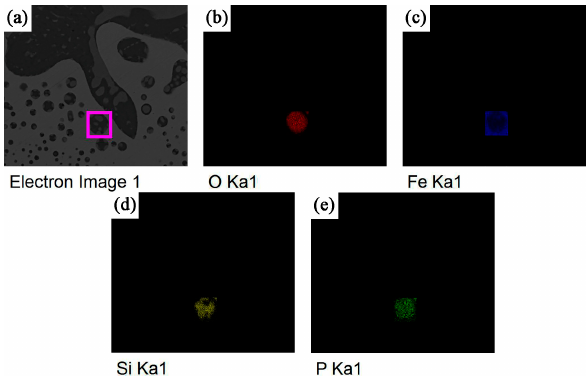
Figure 3. The distributions of chemical elements in the Fe 2 SiO 4 phase ( a ): SiP ‐ 1; ( b ): SiP ‐ 2.